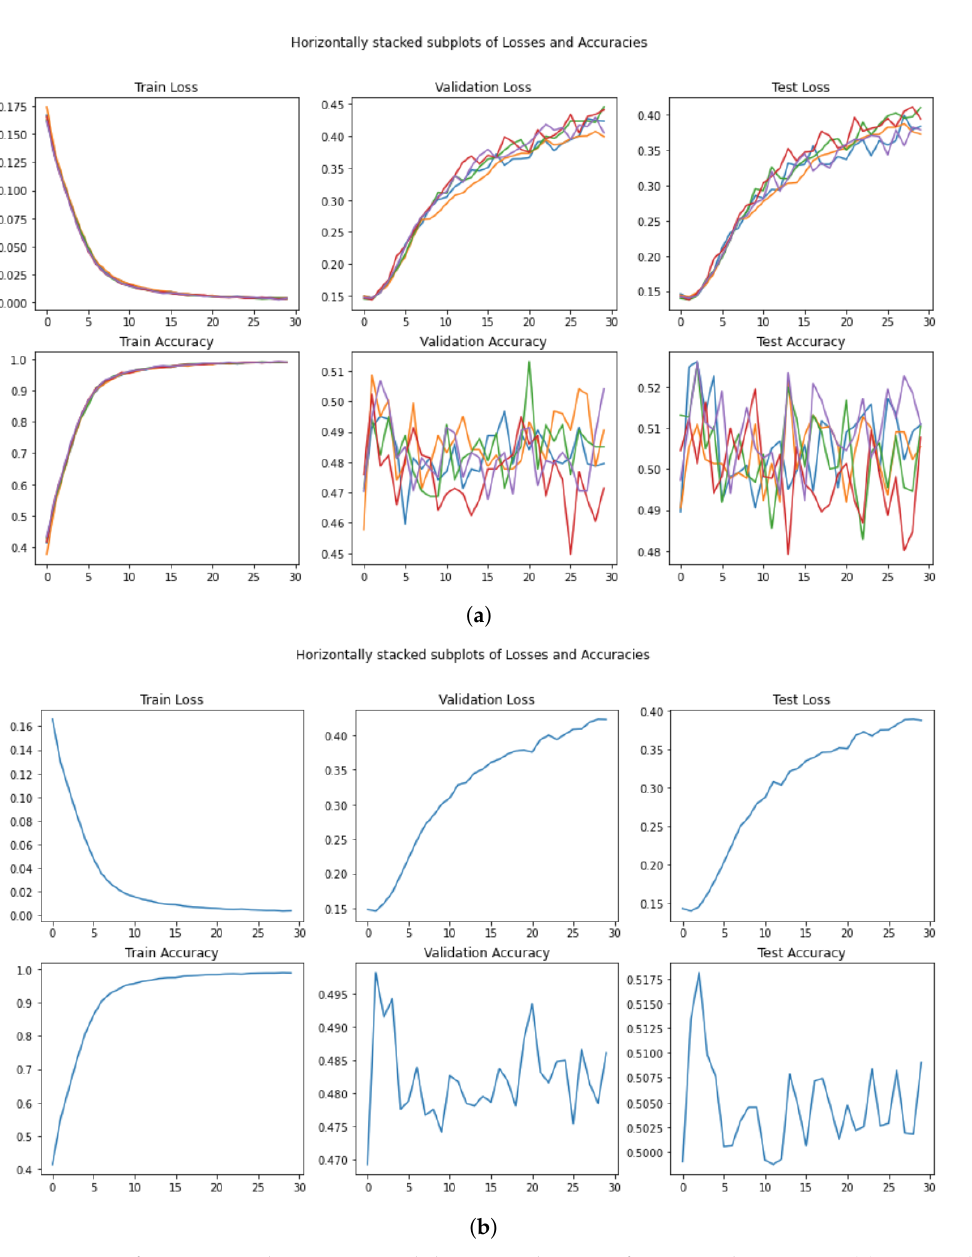
Figure 13. Performance in the training, validation, and test set for in DistilBERT BASE . ( a ) Loss and Accuracy per run and per epoch. ( b ) Mean loss and mean Accuracy per